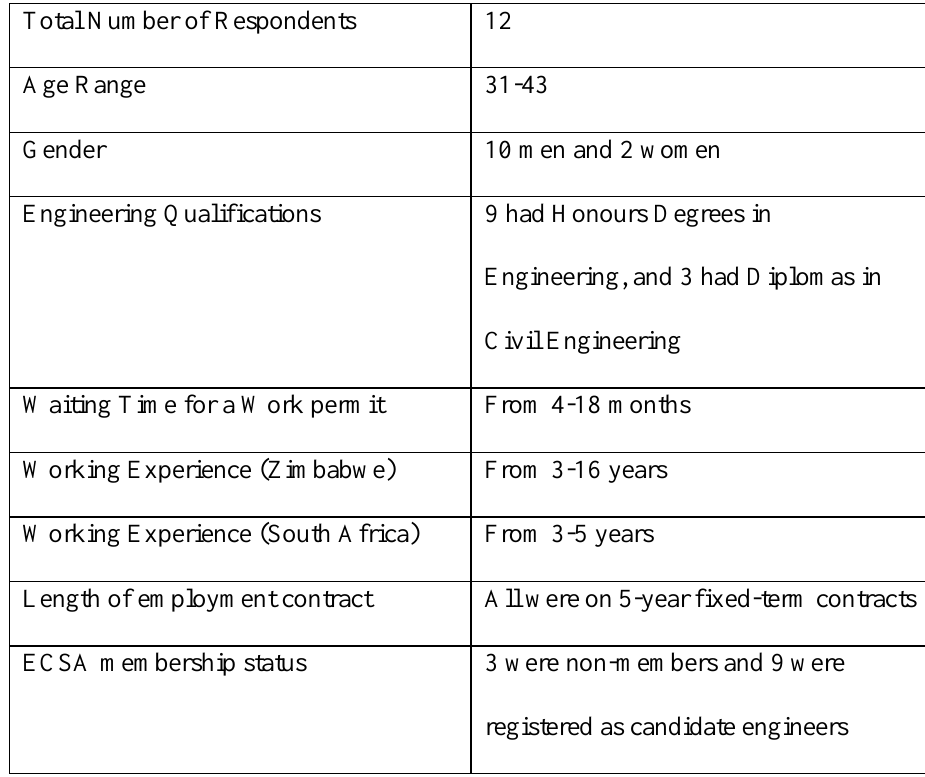
Table 1: Summary of the profile of